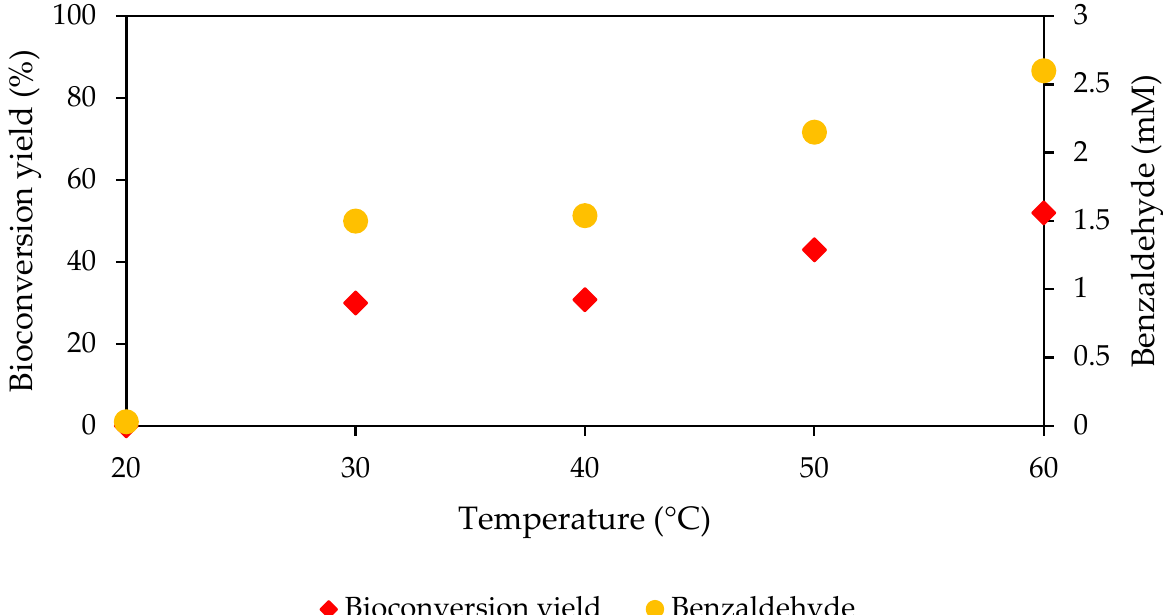
Figure 10. Bioconversion of immobilized carboxylic acid reductase from Mycobacterium phlei ( Mp CAR) onto Seplite LX120. The immobilized Mp CAR was incubated with other assay components for 1 h at temperatures ranging from 20 to 60 ◦ C prior to product analysis using HPLC-UV. The substrate con- centration supplied was 5 mM. The bioconversion yield (%) and benzaldehyde (mM) concentration were